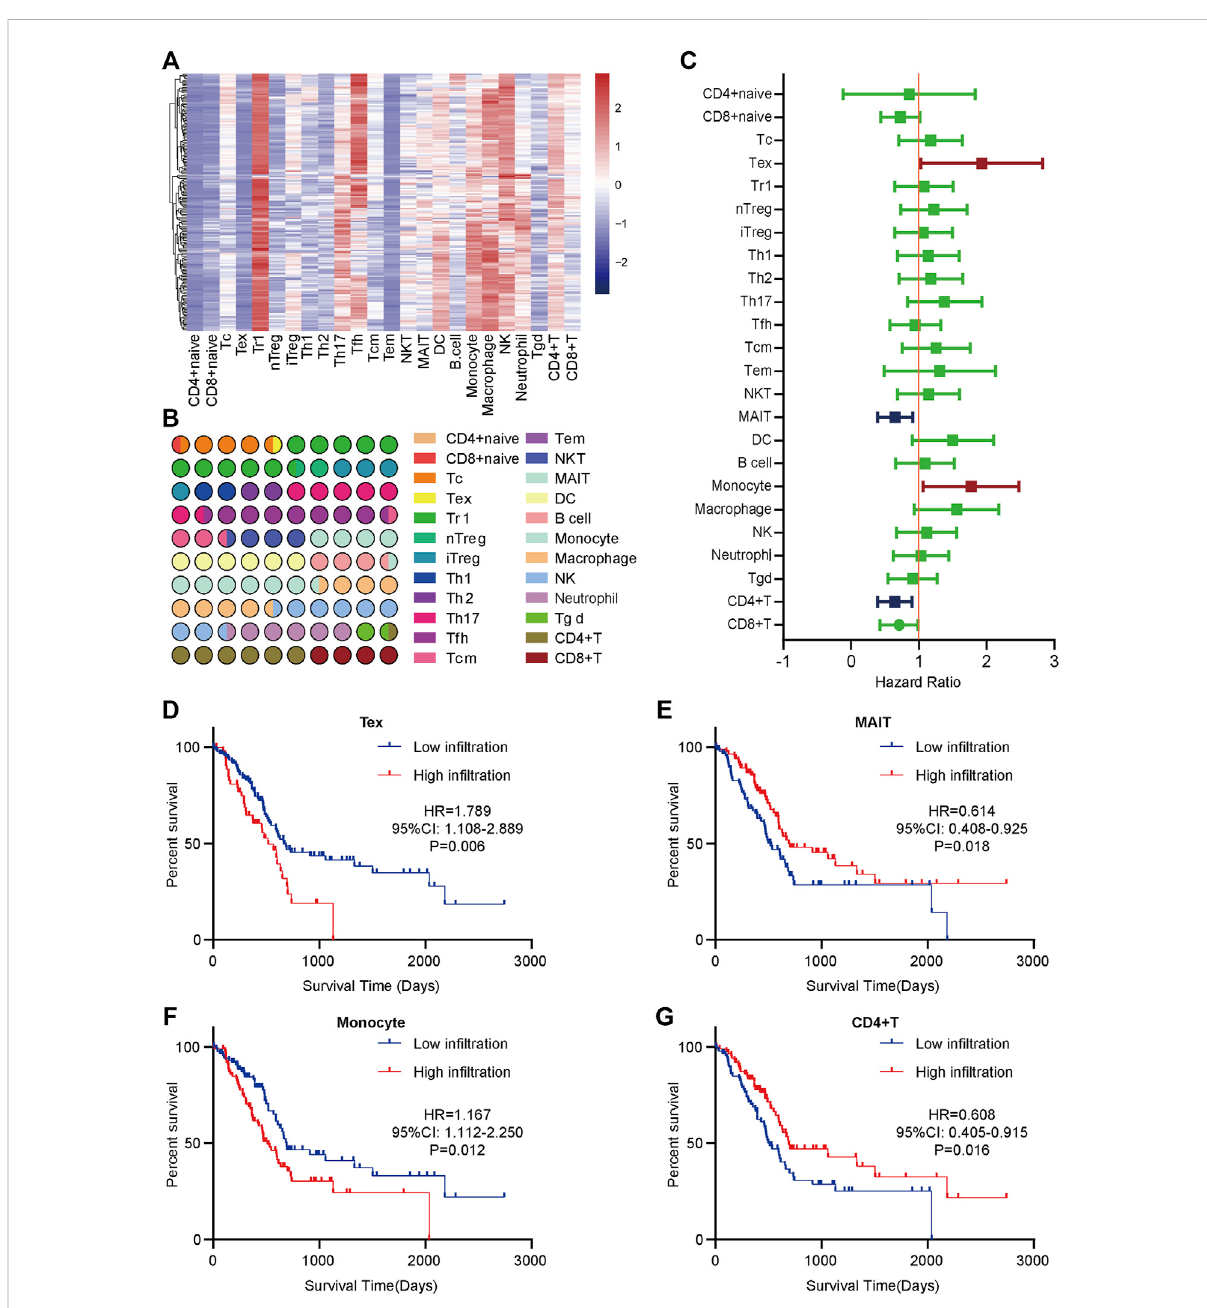
FIGURE 1 The distribution and prognostic roles of TILs in PaCa. (A) The heatmap of the 24 immune cells abundance based on the TCGA data. (B) The proportion of 24 immune cells in PaCa. (C) Overview of Kaplan-Meier analysis of the prognostic values of 24 selected TILs in PaCa. (D) High Tex in fi ltration predicted worse prognosis in PaCa patients. (E) Low MAIT in fi ltration predicted worse prognosis in PaCa patients. (F) High monocyte in fi ltration predicted worse prognosis in PaCa patients. (G) Low CD4 + T cell in fi ltration predicted worse prognosis in PaCa